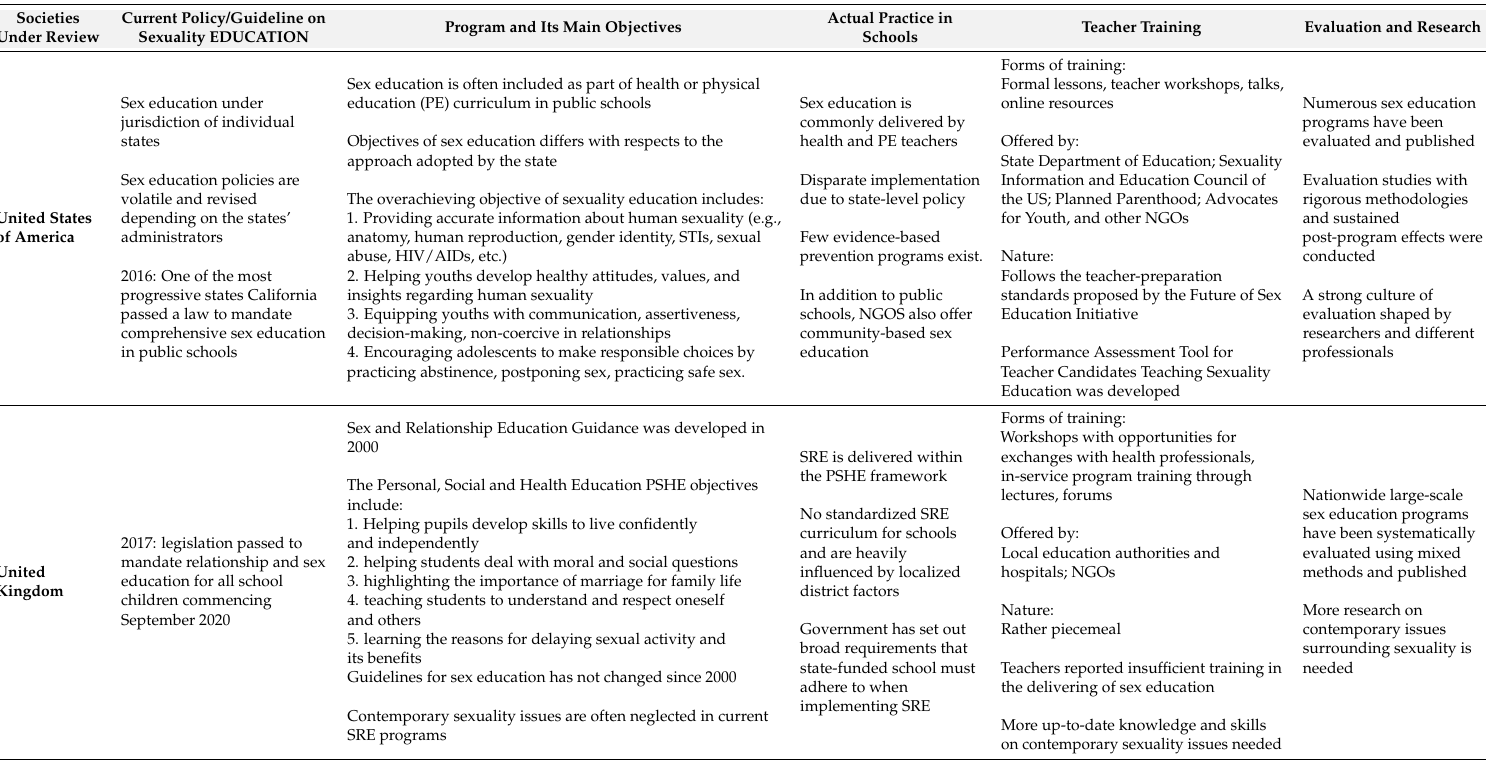
Table 1. Summary of sex education aspects in the two large English-speaking